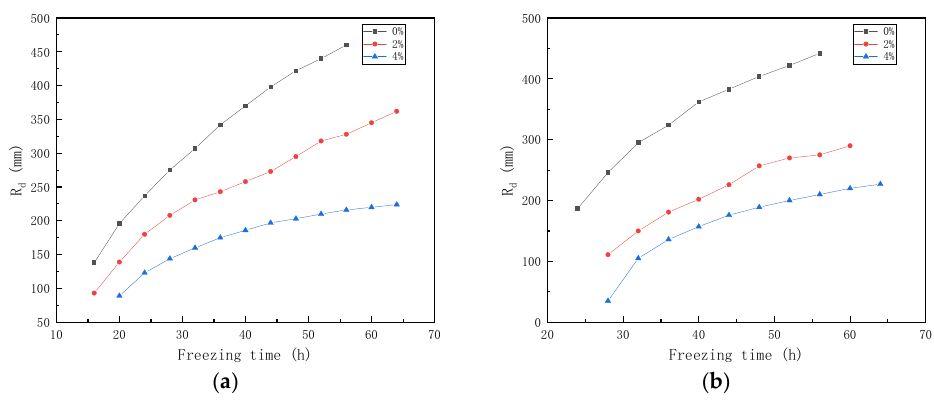
Figure 14. The developments of R d at ( a ) 3 m/d; ( b ) 6 m/d. The frozen curtain area can reflect the development of the freezing. Therefore, the shows the development curves of the frozen curtain. Different from the development